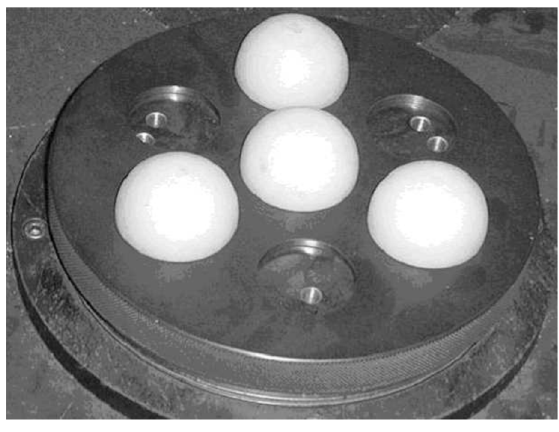
Figure 15. Four half-spheres served as the impact target.